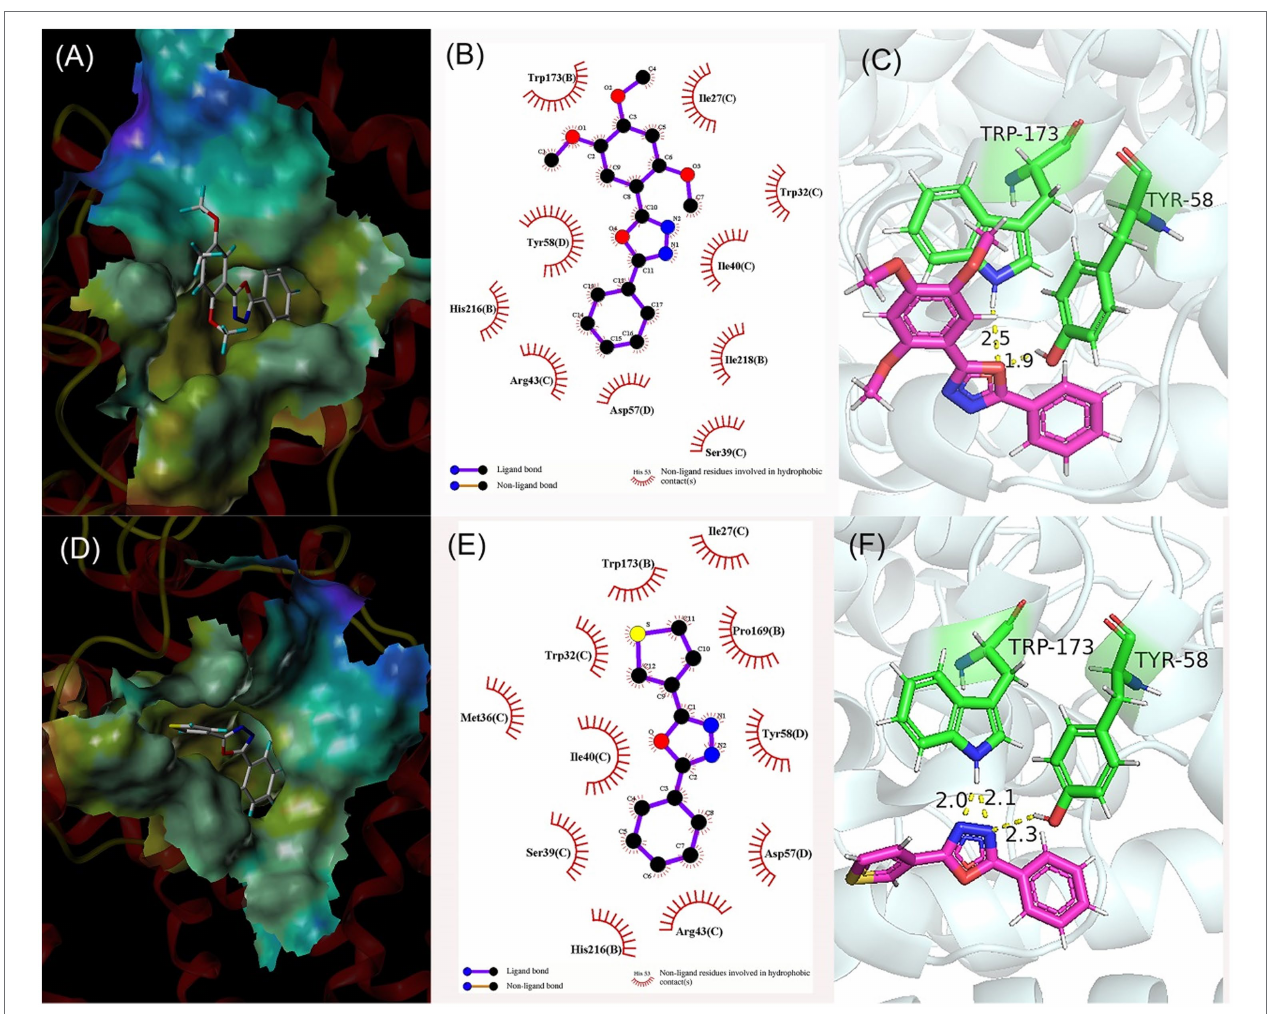
FIGURE 4 | Molecular docking results of compound 5e (A–C) and compound 5k (D–F) . (A,D) Predicted binding mode of compound within active pocket; (B,E) Predicted interactions between compound and amino acids; and (C,F) Binding modes of compound and amino